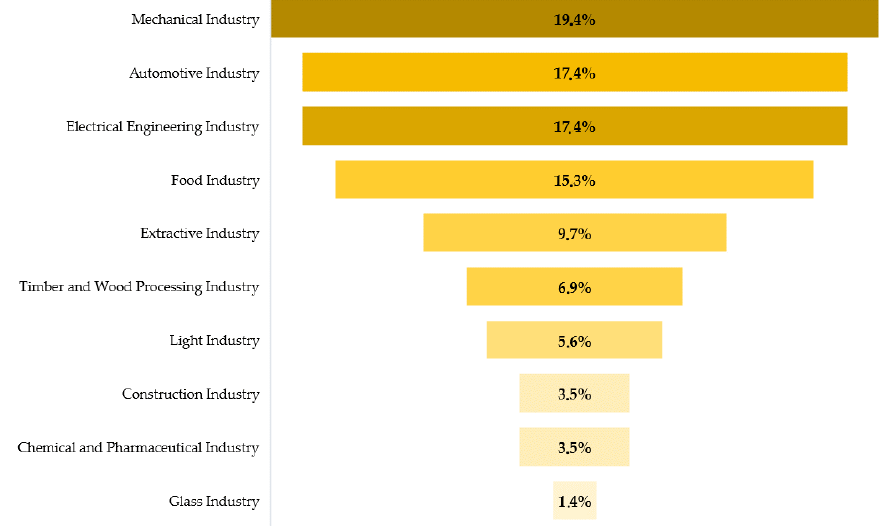
Figure 4. Data file structure by industrial sector. Source: Author's own.